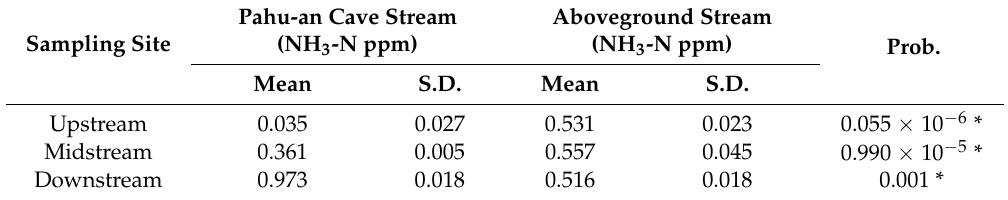
Table 5. Ammonium content